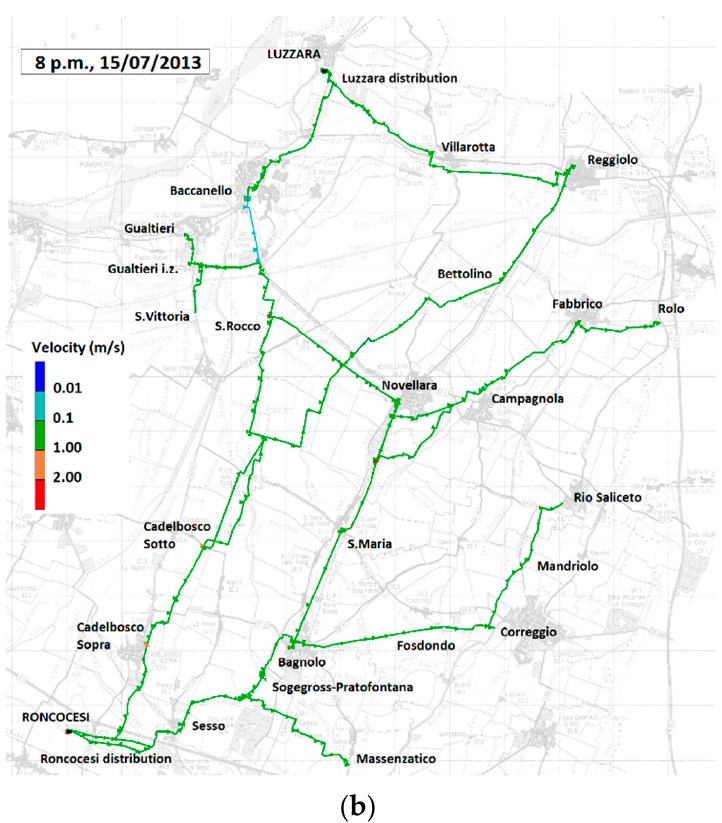
Figure 5. Hydraulic simulations of Roncocesi and Luzzara water supply systems over the day of highest consumption, i.e., 15 July 2013 at 8 p.m. ( a ) Flows, and ( b ) velocities inside the networks. Table 3. Daily average water demand (dm 3 /s) from the localities served by Roncocesi and Luzzara networks over the day of higher consumption, i.e., 15 July 2013.